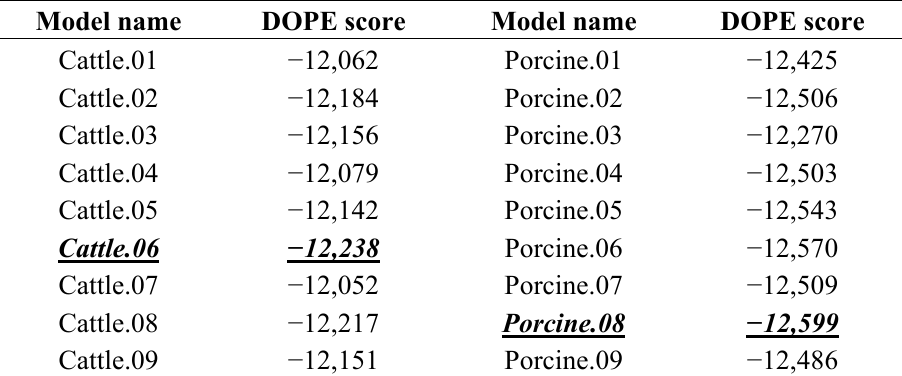
Table 3. DOPE scores of cattle and porcine